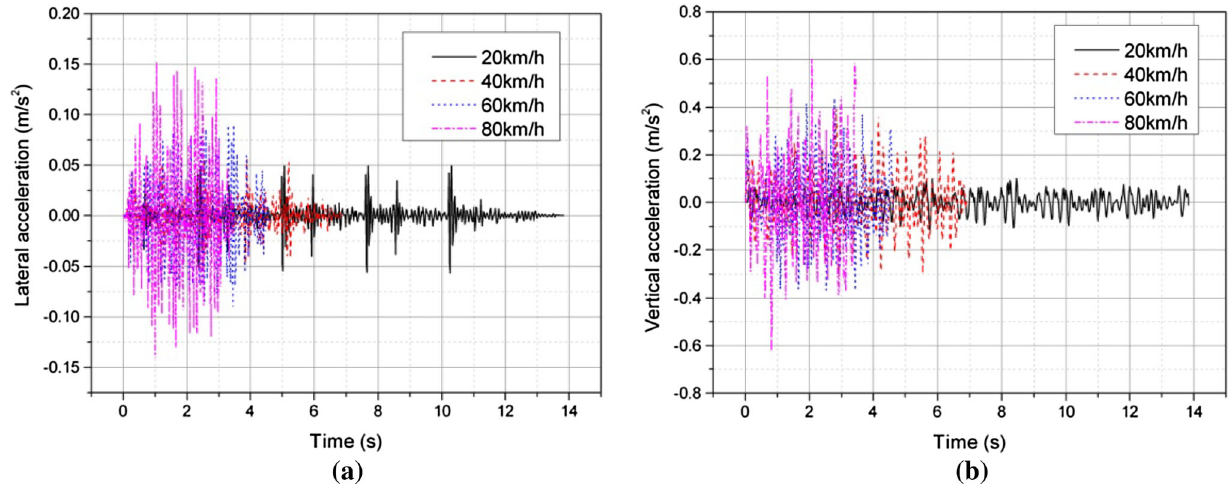
Fig. 10 History of acceleration at middle span (unit: m/s 2 ). a Lateral, b vertical